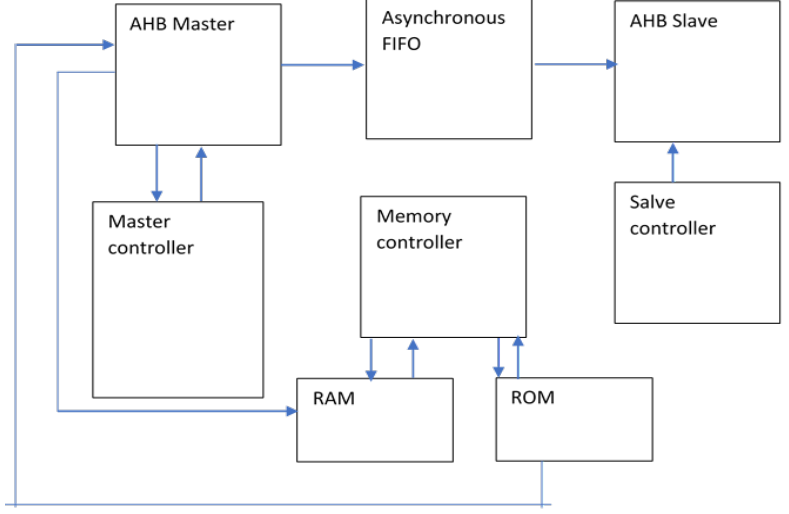
Fig. 2. Proposed system architecture of AMBA with Memory